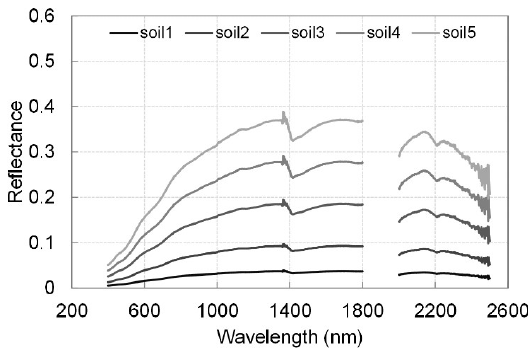
Figure 4. Soil reflectance used for the simulations in the PROSAIL-D model. Soil5 reflectance is the field measurement. The others are the soil5 spectrum multiplied by various brightness coefficients.